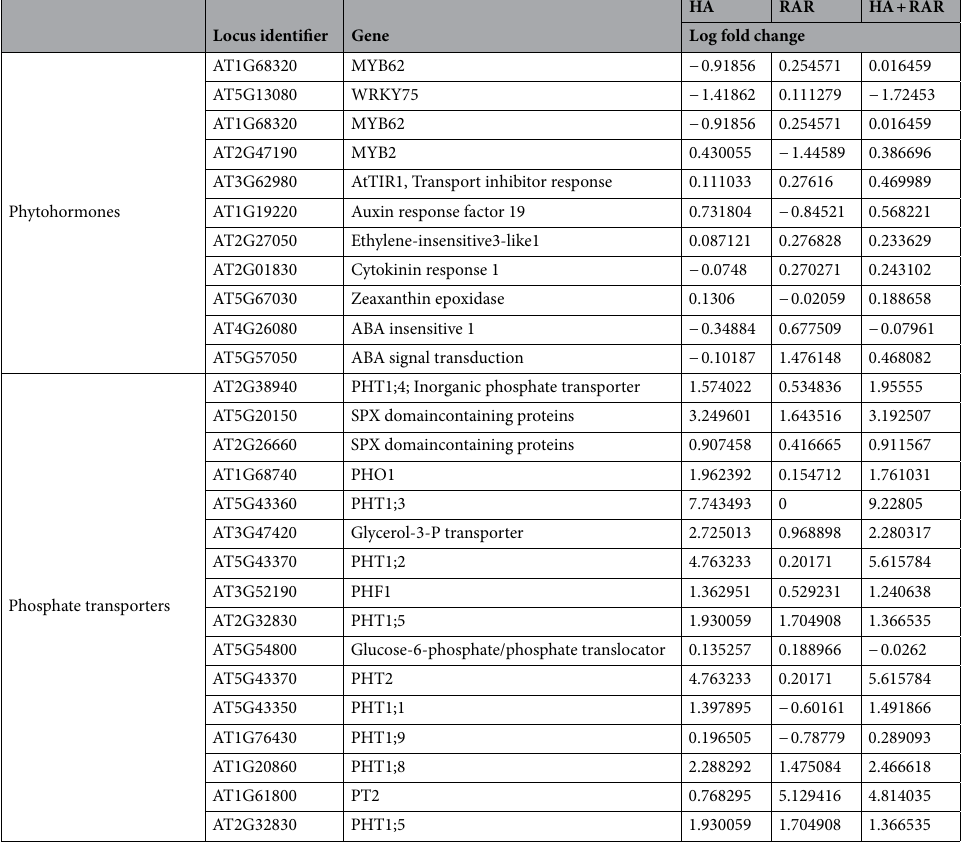
Table 2. Log fold change value of genes associated with plant growth promotion, root system architecture, defense metabolism, phytohormones, and phosphate transport in HA, RAR, and HA + RAR